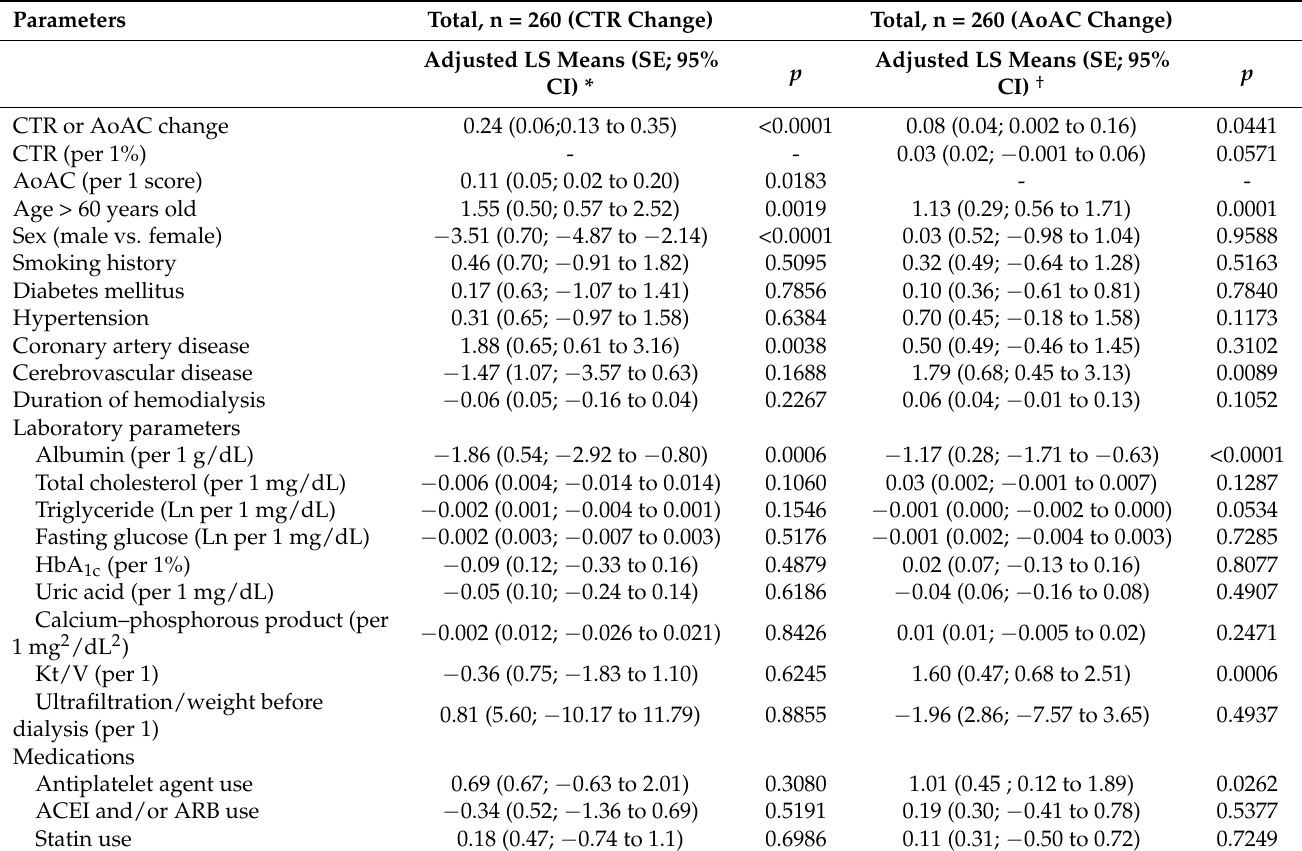
Table 3. Main effects of the variables on CTR or AoAC change over year in hemodialysis patients.